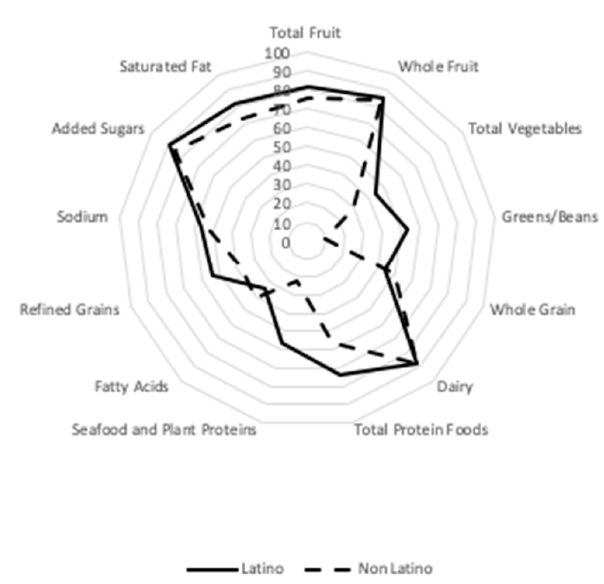
Figure 1. Radar chart of HEI-2015 for 119 FCCH by income.